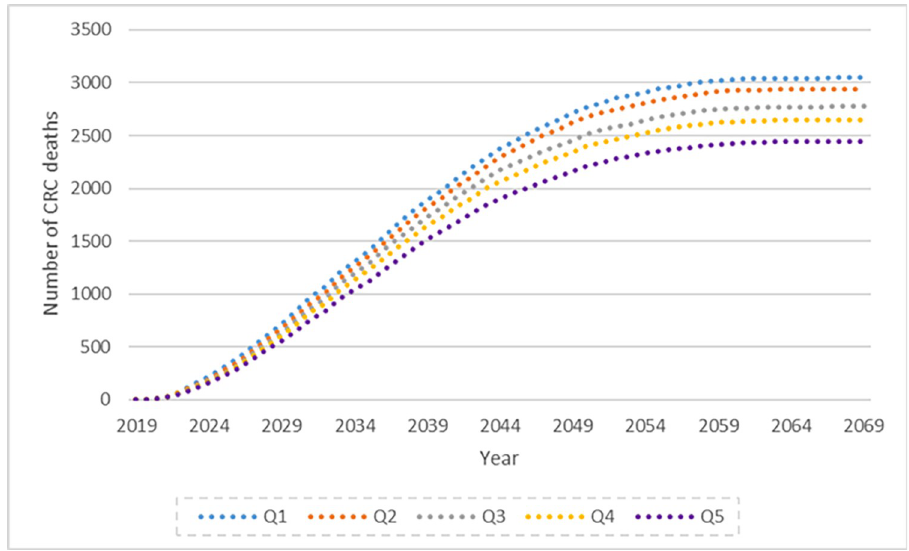
Fig 3. Predicted CRC deaths aged 50–74 years over the period 2019–2059 by SEIFA